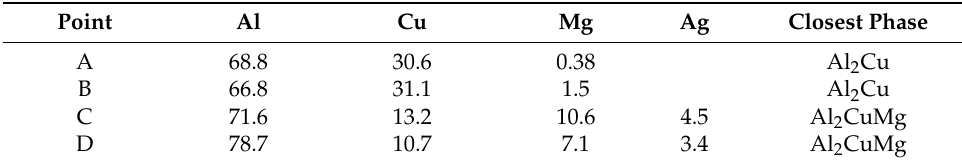
Figure 4. EDS elemental distribution of QISOZ. Table 2. EDS results for each point in Figure 2d (at.